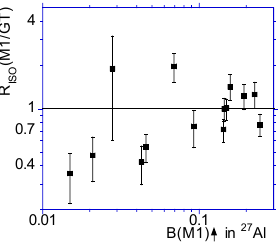
Figure 2. The ratio R ISO for the M 1 transitions in 27 Al as a func- tion of B ( M 1) . (Note the log-log scale of the figure.) The ratio ↑ is sensitive to the combined contribution of IS term and IV or- bital term to each M 1 transition. Values of R ISO > 1( < 1) suggest constructive (destructive) interference of these terms with the IV spin term. For the definition of R ISO , see